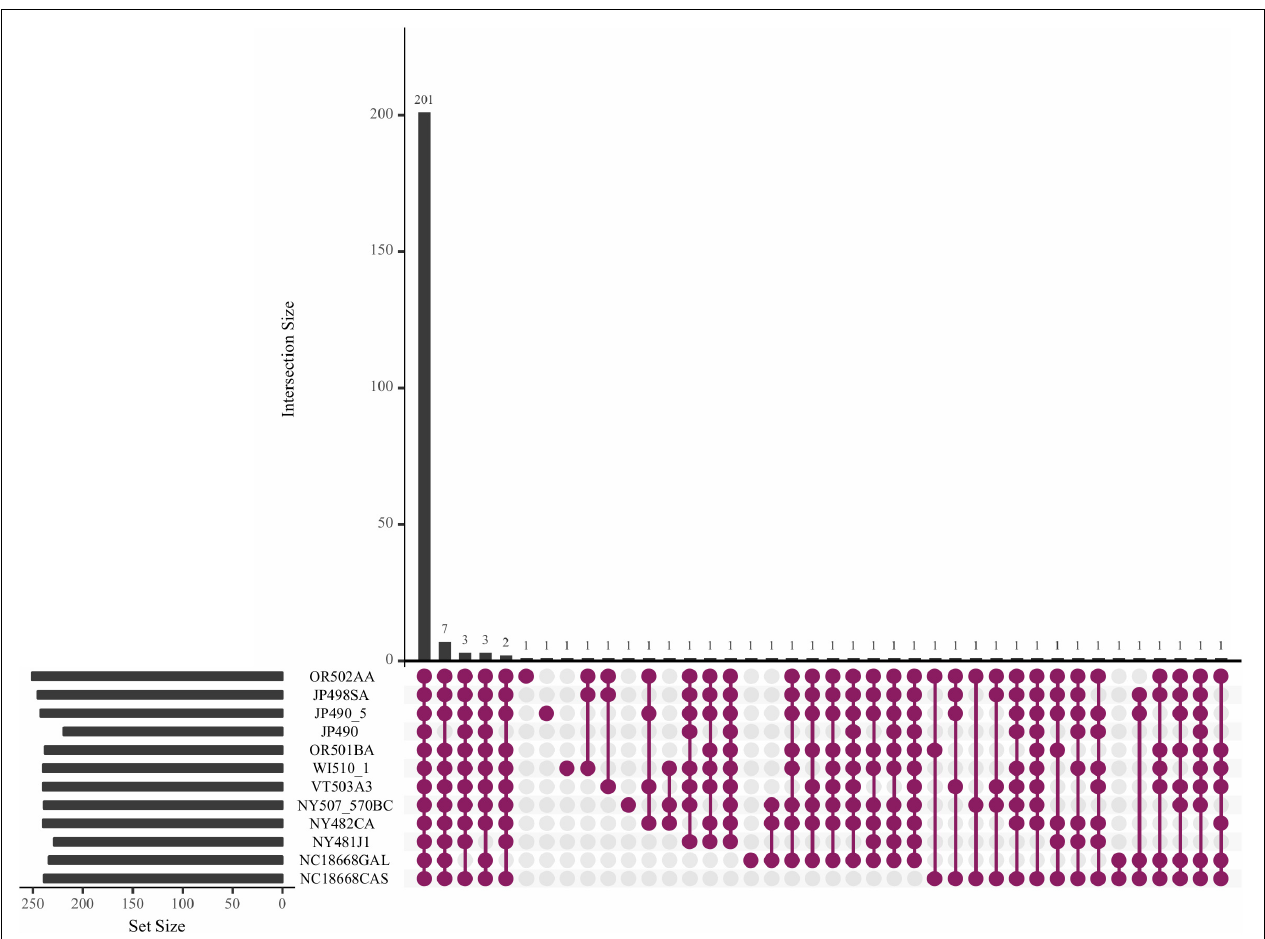
FIGURE 3 | Upset plot showing the trend of effector transcripts in the sporangia of Pseudoperonospora humuli isolates. RNAseq reads from sequenced sporangia of different isolates were mapped to P . humuli gene calls (Rahman et al., 2019) using TopHat version 2.0.6 (Trapnell et al., 2009). Reads were counted using the HTSeq python module (Anders et al., 2014) and reads per kilobase million (RPKM) values were calculated. An RPKM > 0 was used to indicate the presence of a transcript. The plot was generated using the R package UpsetR (Conway et al.,